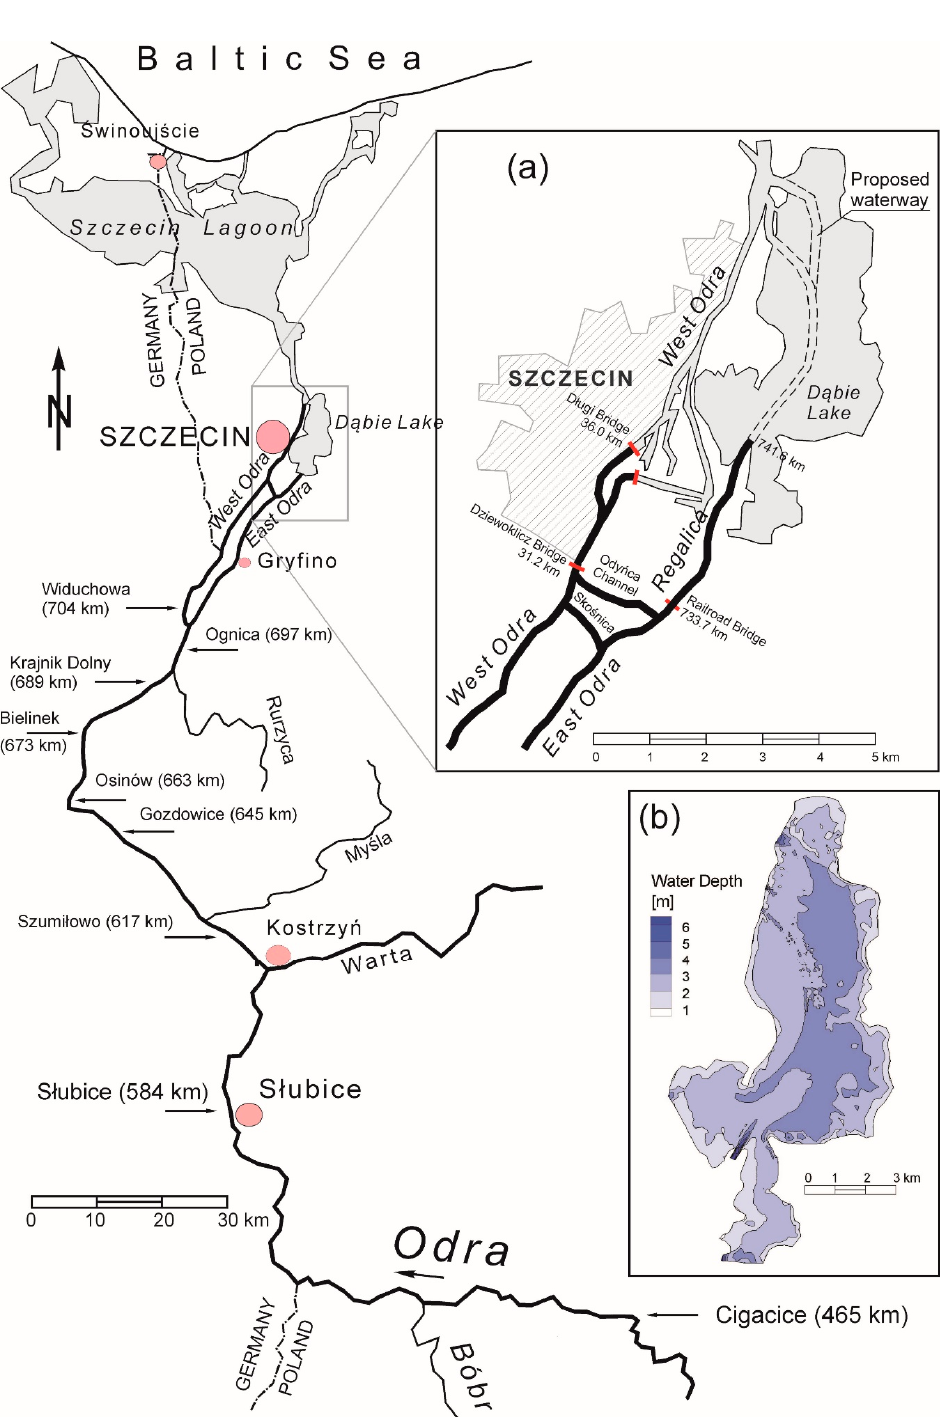
Figure 1. The Lower and Middle sections of the Odra River—the arrows indicate ice jam-prone locations with river mileage: ( a ) details of the Szczecin Water Junction and Lake D ą bie; ( b ) water depth in Lake D ą bie for average discharge Q = 575 m 3 /s.